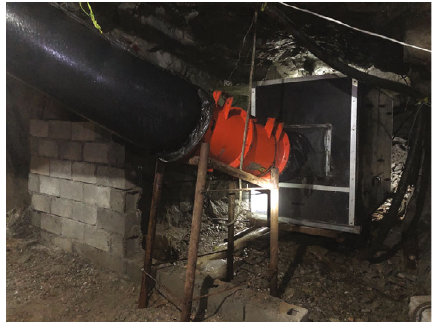
Figure 8: The auxiliary forced